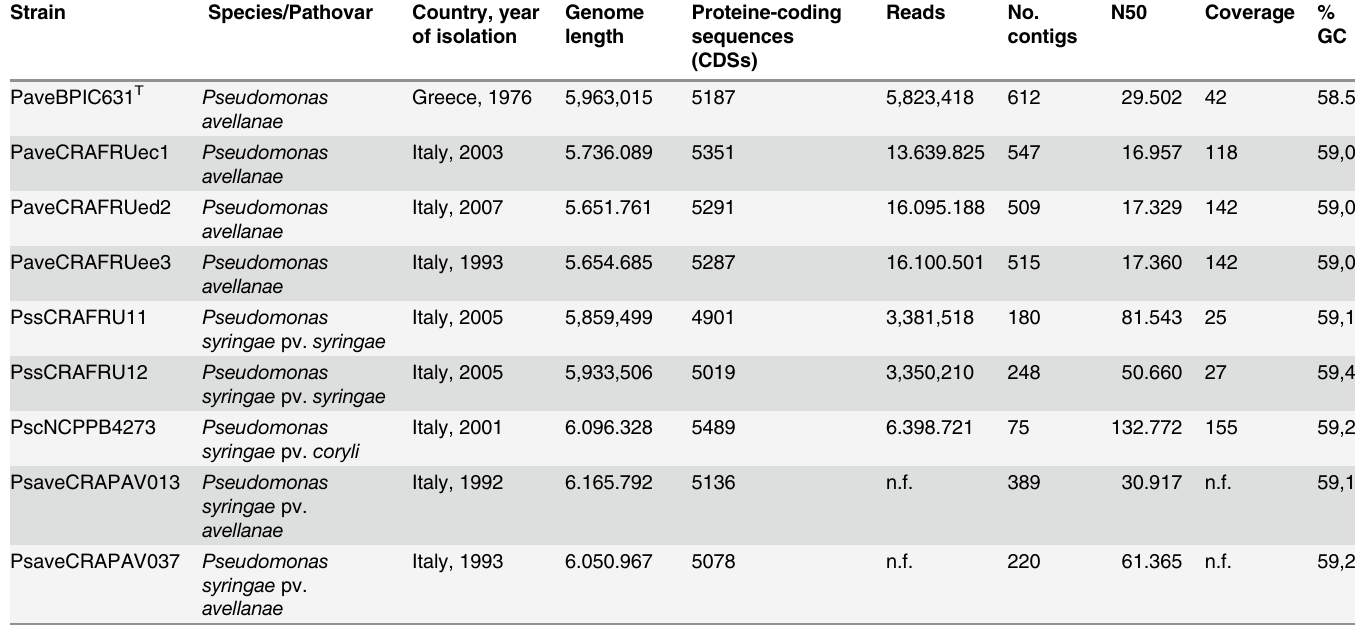
Table 1. General features of draft genomes for the phytopathogenic Pseudomonas strains causing infection to Corylus avellana trees assessed in this study. Strain